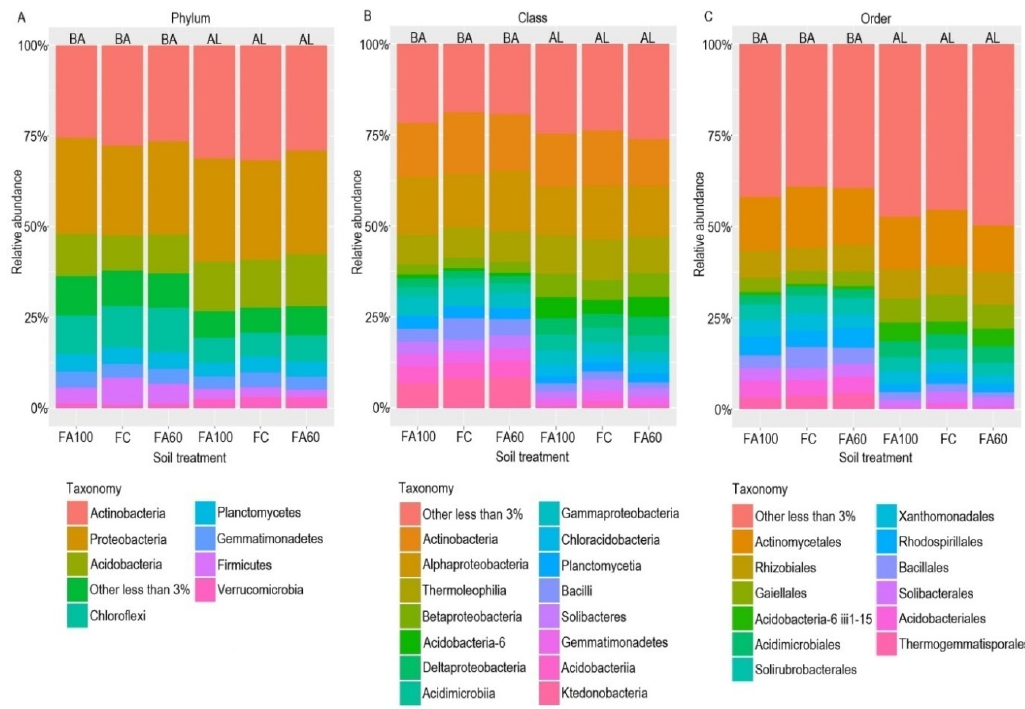
Figure 8. Distribution of bacterial phyla ( A ), classes ( B ) and orders ( C ) obtained by next generation sequencing of DNA extracted from soil samples. Explanation: BA—Brunic Arenosol, AL—Abruptic Luvisol, FC—optimal dose of fertilizer, FA100—optimal dose of fertilizer enriched with microorganisms, FA60—fertilizer enriched with microorganisms (dose reduced by 40%).